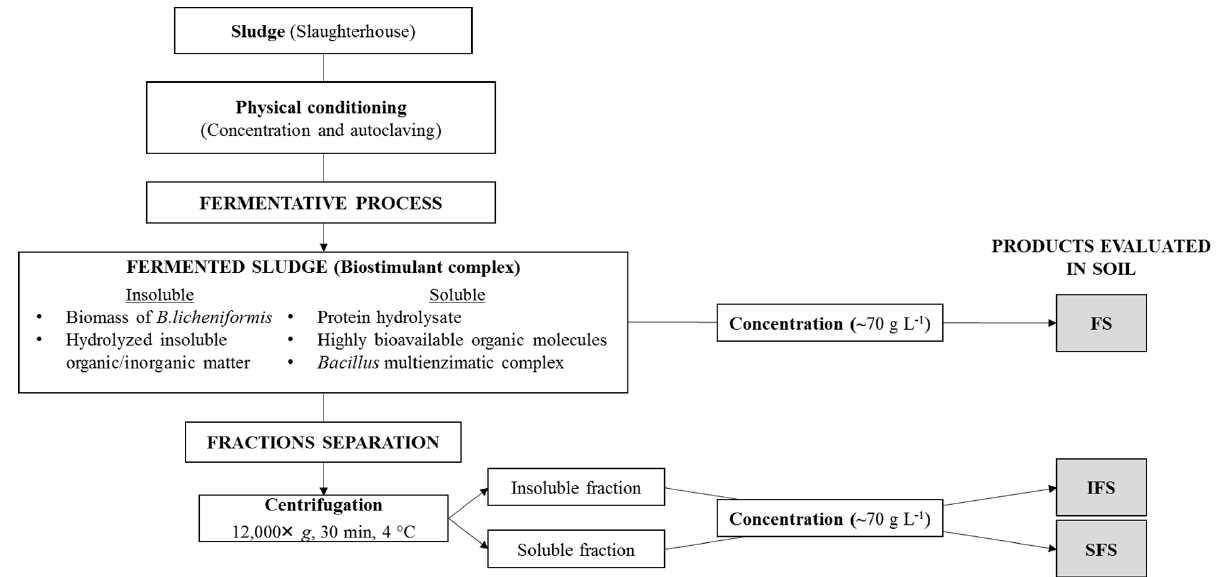
Figure 1. A diagram of the process to obtain the experimental products.